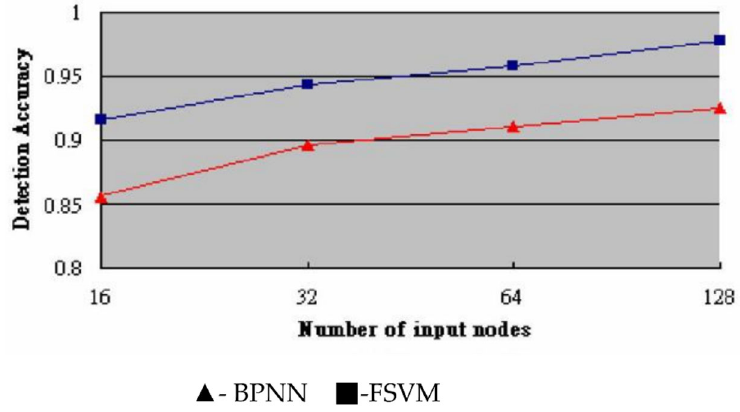
Figure 5. Average detection accuracy of FSVM vs. BPNN.